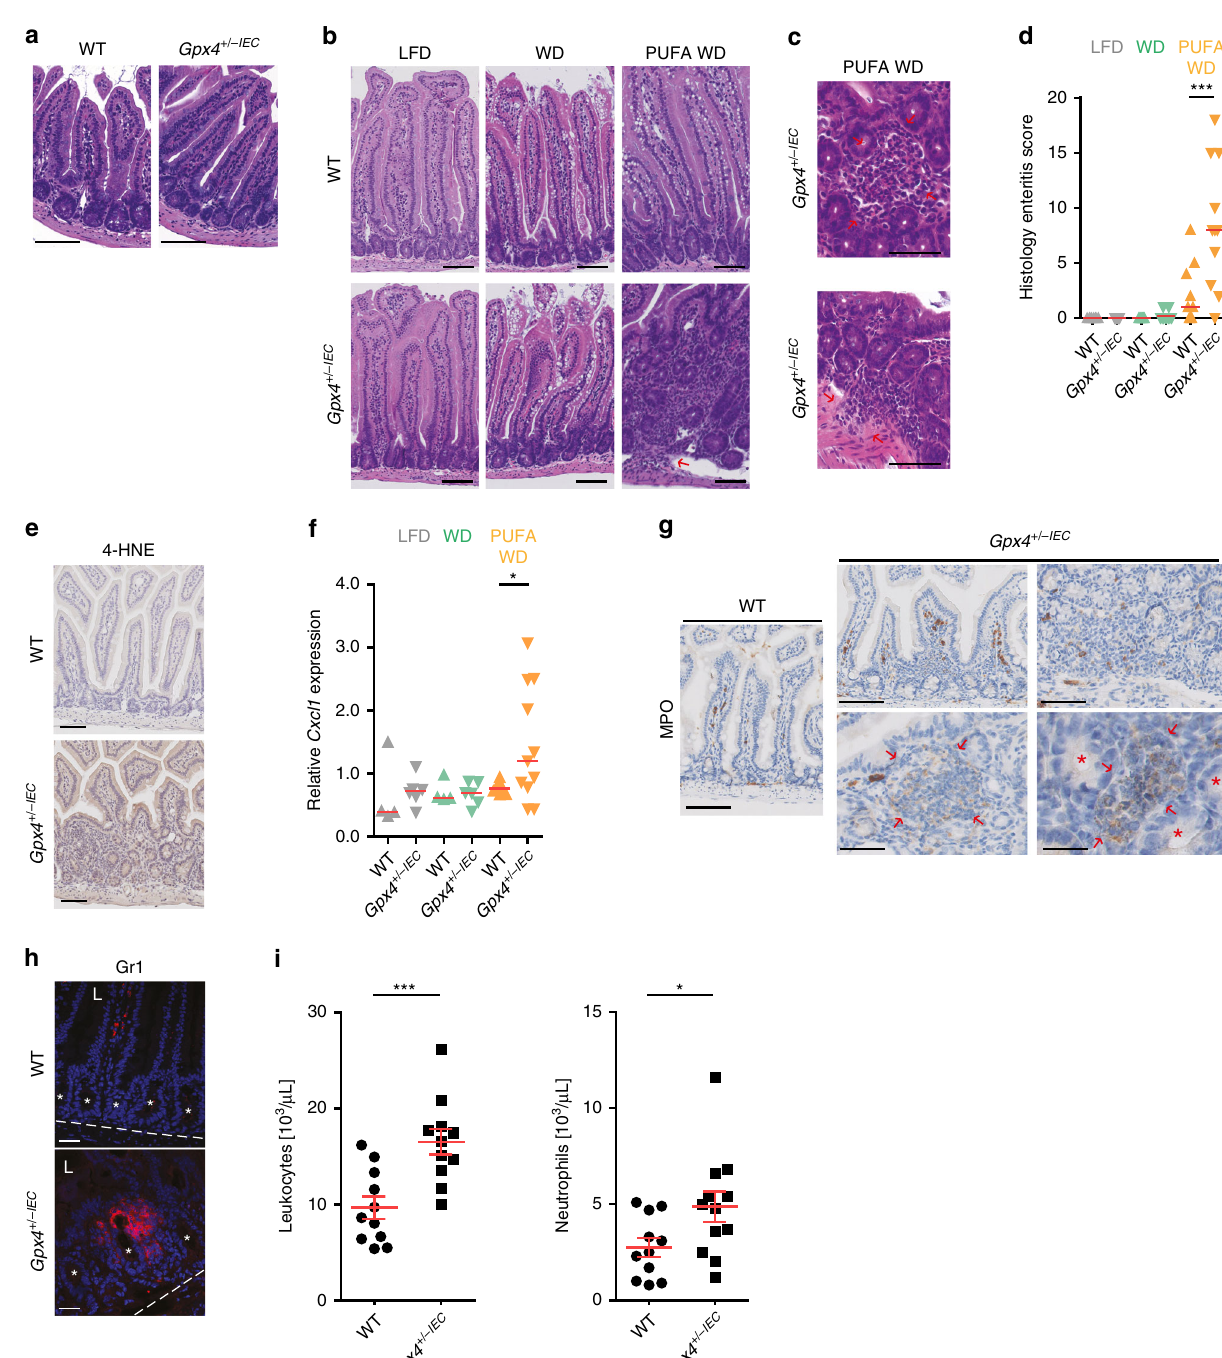
IECs to some extent (Supplementary Fig. 6A-I), we did not observe IEC death in Gpx4 + / − IEC mice on a PUFA-enriched Western diet (Supplementary Fig. 6J-L). These data indicated that cell death was not a prerequisite of PUFA-induced and GPX4-restricted intestinal in fl ammation in Gpx4 + / − IEC mice. Cytokine production is driven by ferroptosis mechanisms . We focused on regulatory mechanisms that control AA-induced cytokine production because AA entails a risk for developing IBD 20,21 . As we noted that AA stimulation promoted LPO only in Gpx4 -de fi cient IECs (Fig. 2a) and cellular iron availability and lipoxygenases (LOX) control LPO in Gpx4 -de fi cient cells 1,30 ,